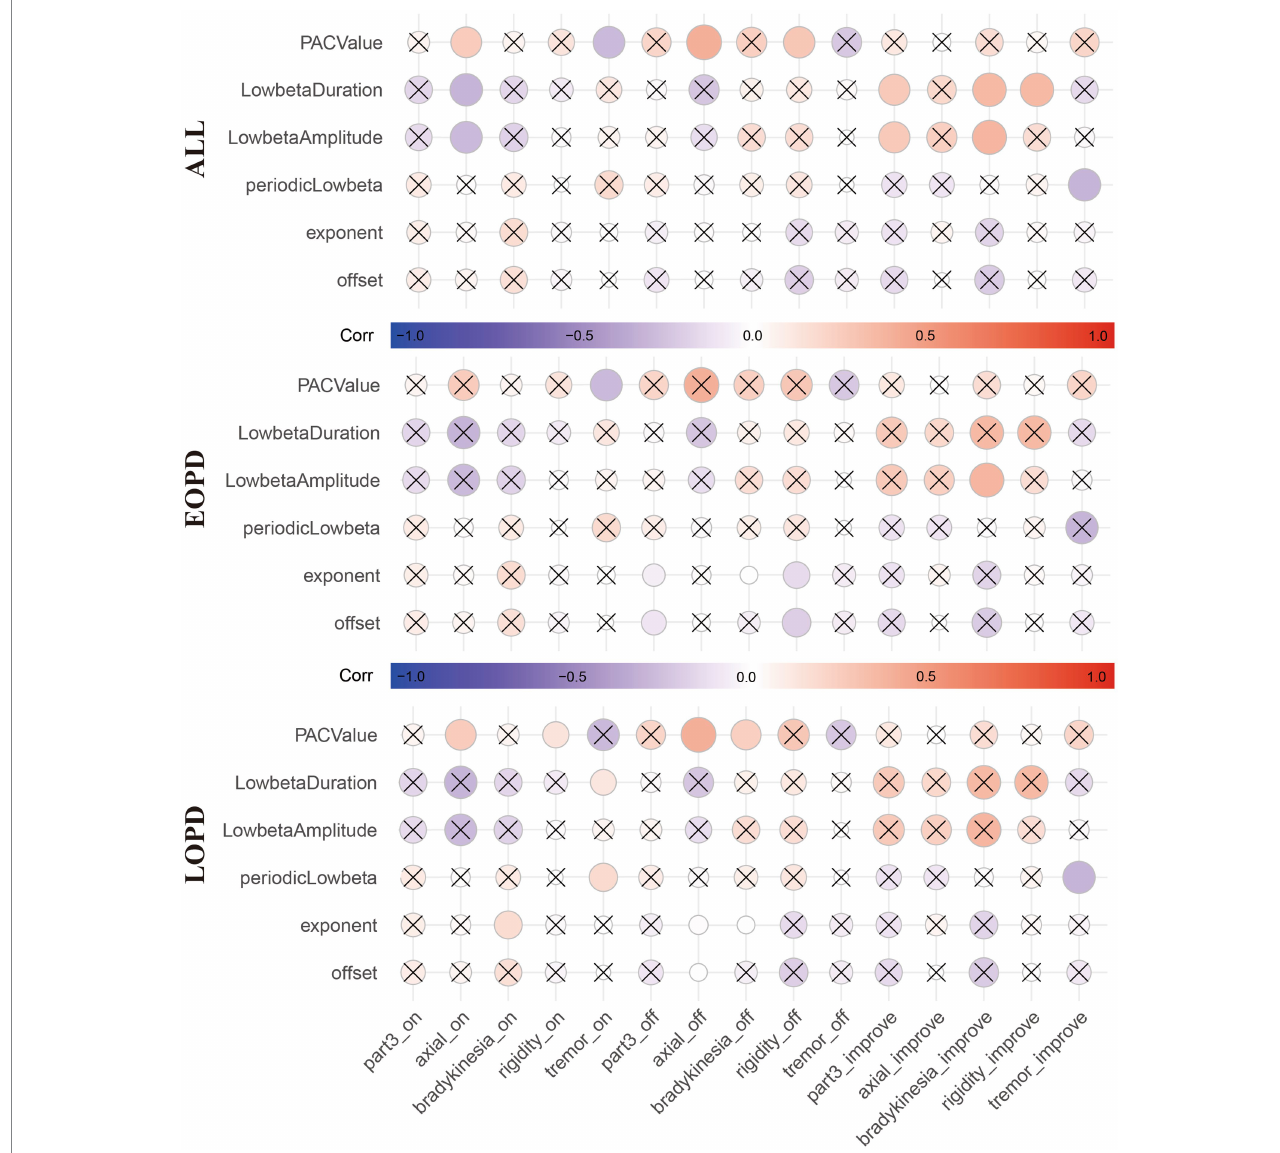
FIGURE 6 The correlation matrix shows the correlation between the local field potential (LFP) parameter and motor symptom scores (total scores and subdivided scores) and improvement rates in all patients (Top) , EOPD (Middle) and LOPD (Bottom) , respectively. Red represents positive correlation and blue represents negative correlation. Circles with uncorrected p values greater than 0.05 were crossed. However, after FDR correction, there were no significant correlations between LFP parameters and the motor scores (including total scores and subdivided scores), neither within whole population nor each group, respectively. *_on indicates Med ON. *_off indicates Med OFF. *_improve indicates improvement